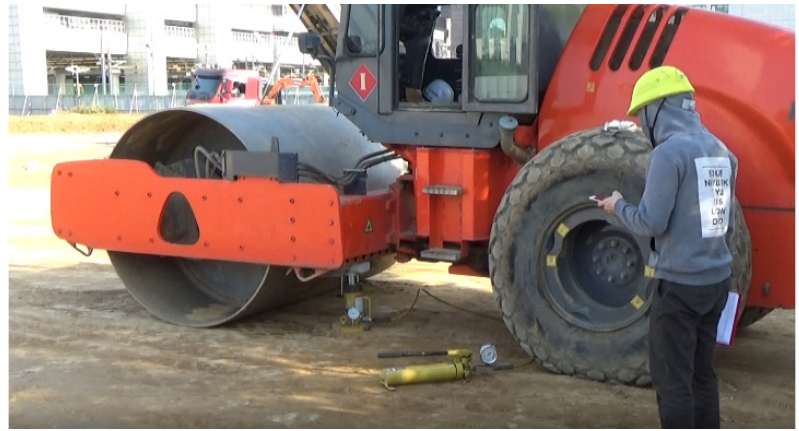
Figure 7. Plate load test arrangement at the construction site. Table 6. Plate load test results.